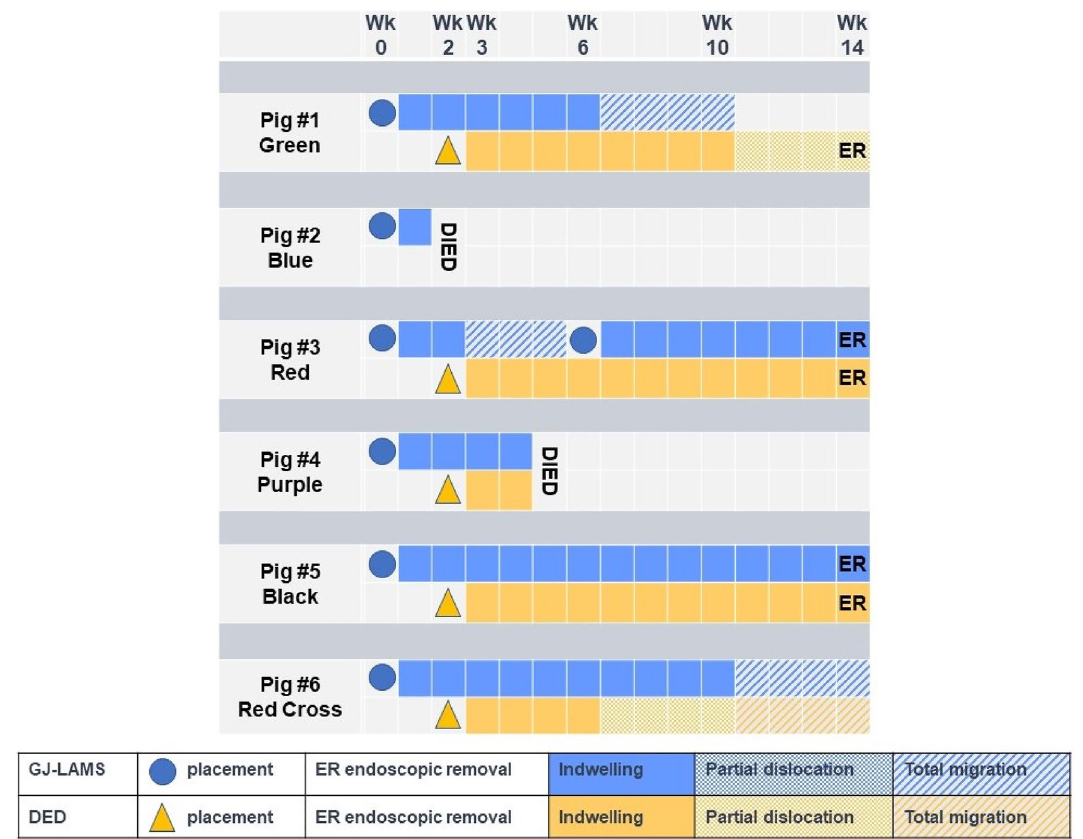
Figure 2. Placement, removal and migration of GJ-LAMS and DED in adult domestic